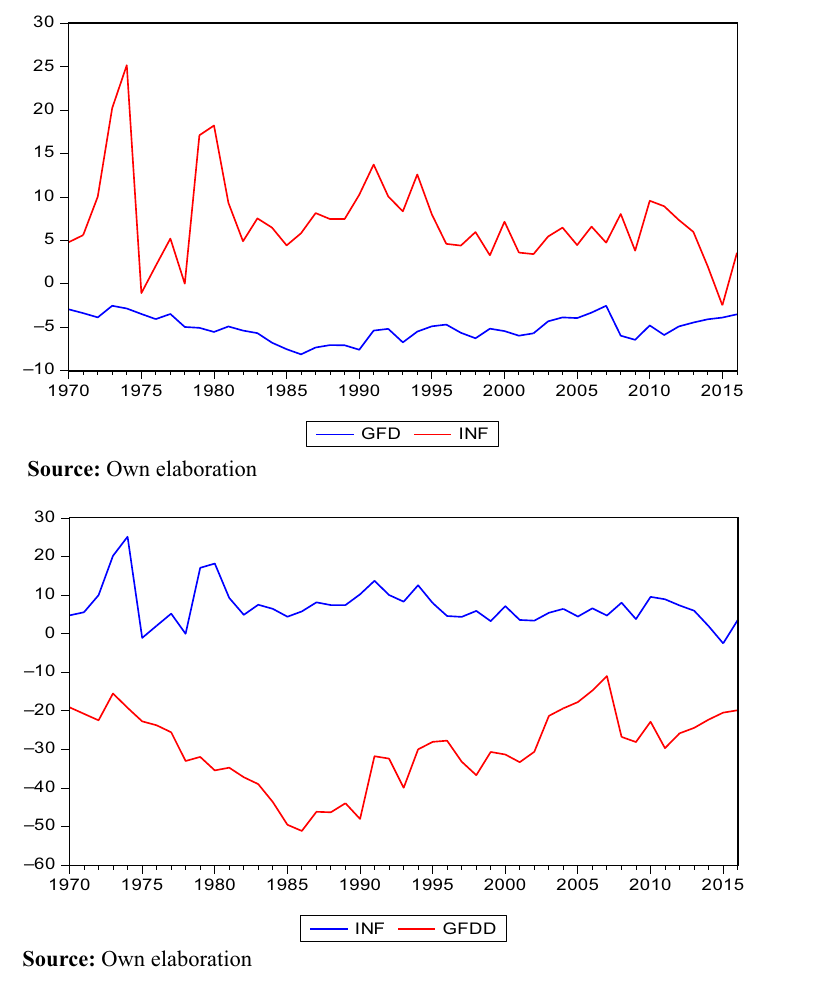
Figure 2. INF rate and fi scal de fi cit as a percentage of narrow